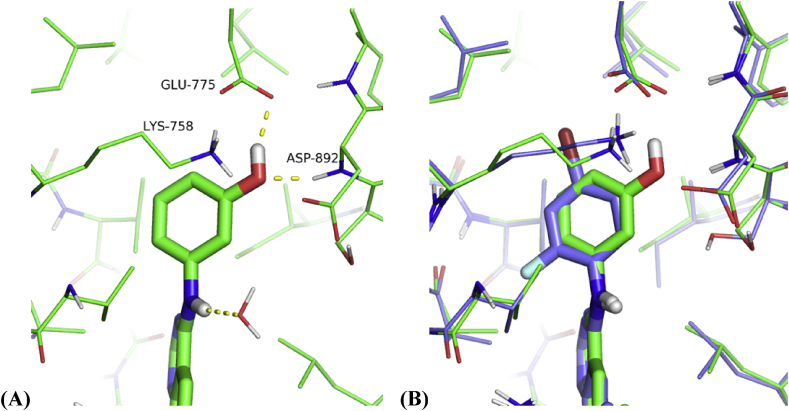
Detail of phenol interactions in the gatekeeper pocket of RET X-ray structures. (A) Crystal structure of compound 6 bound to RET kinase domain, highlighting hydrogen-bonding interactions to Glu775 and Asp892N–H (PDB 5AMN). (B) Comparison of compound 6 with the published structure of 1 (PDB 2IVU, carbon atoms in purple). Hydrogen atoms modelled using Maestro and figure prepared using the Pymol Molecular Graphics System (Schrödinger, LLC, New York, NY). (For interpretation of the references to colour in this figure legend, the reader is referred to the web version of this article.)